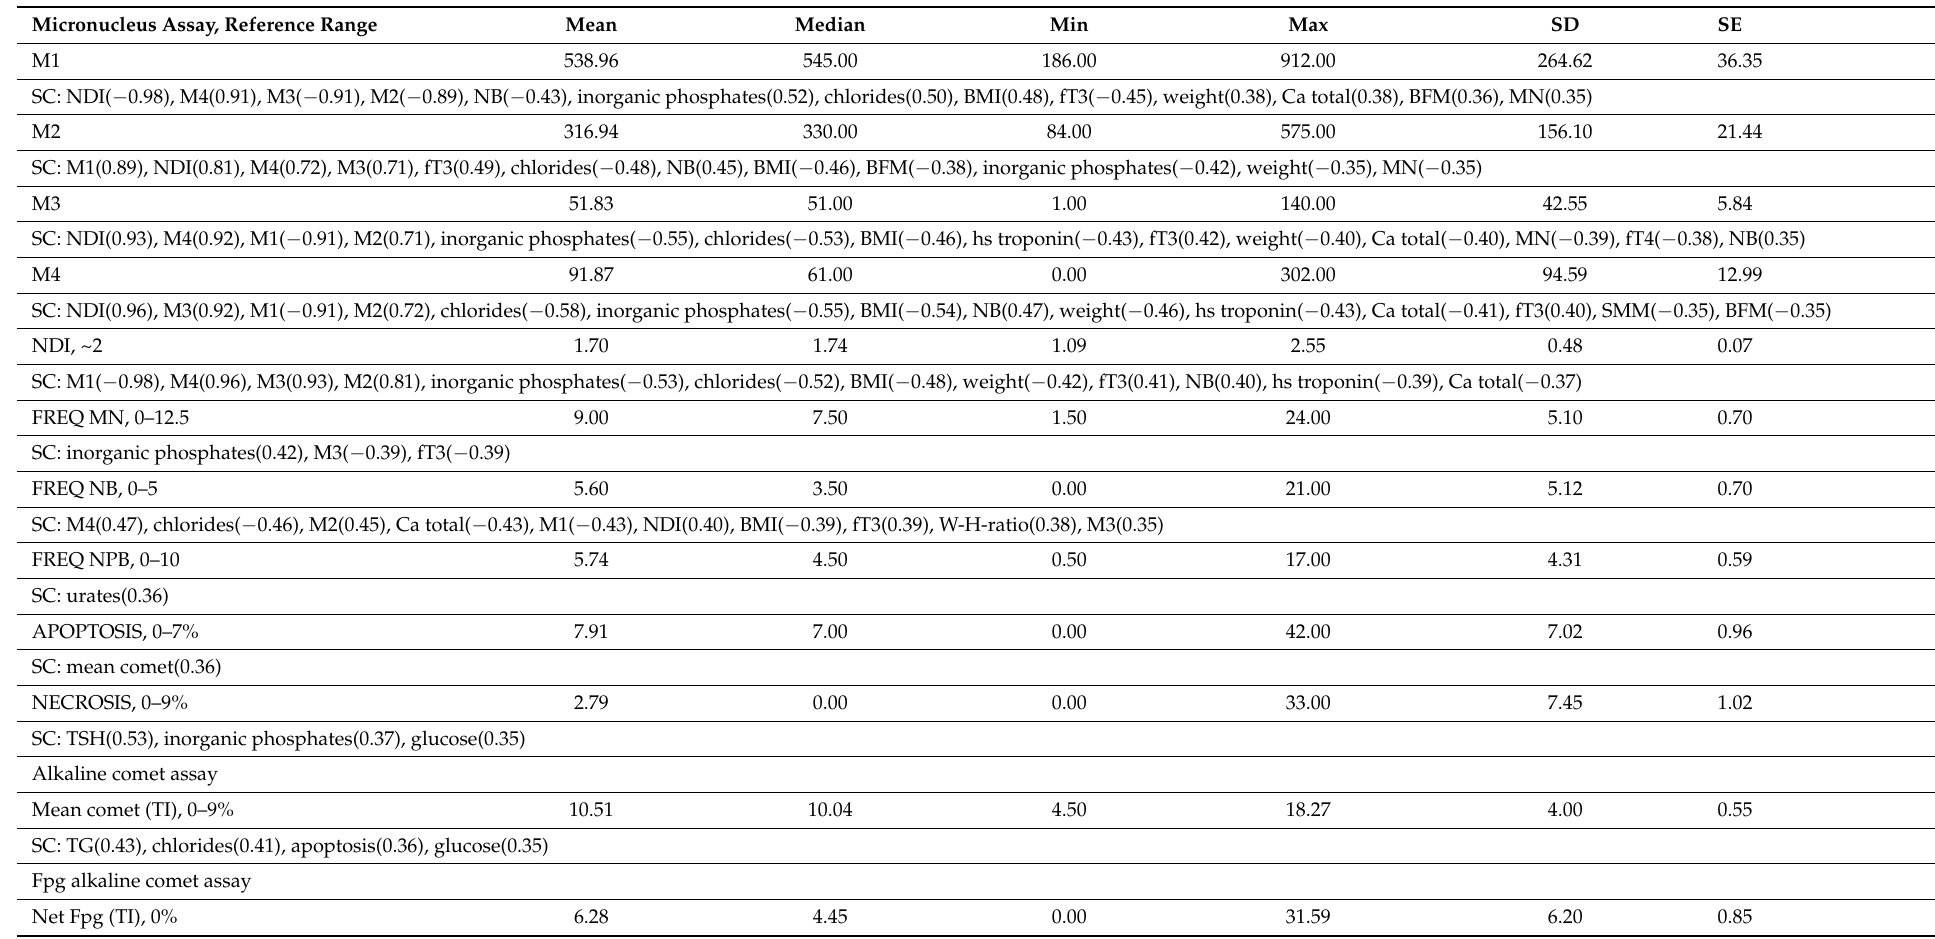
Table 3. DNA damage parameters measured in all three assays on the group level (n = 53) with Spearman correlation